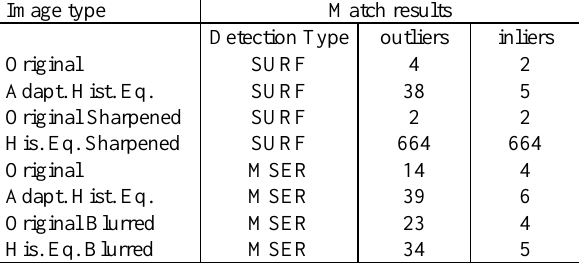
Table 2. Results of the experiment 1